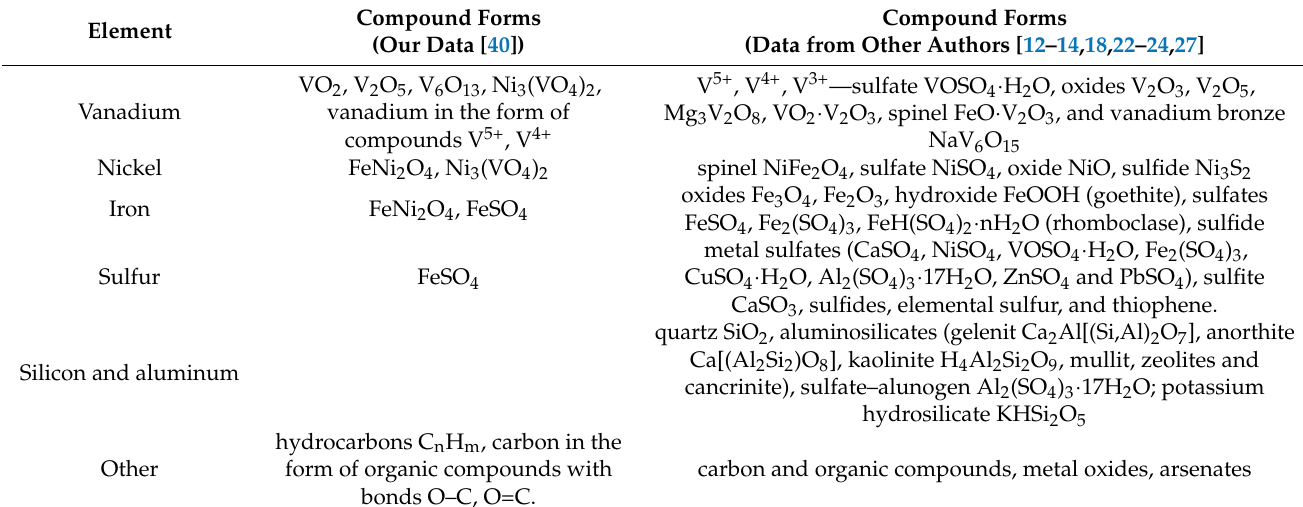
Table 2. Forms of compounds of elements in ash.